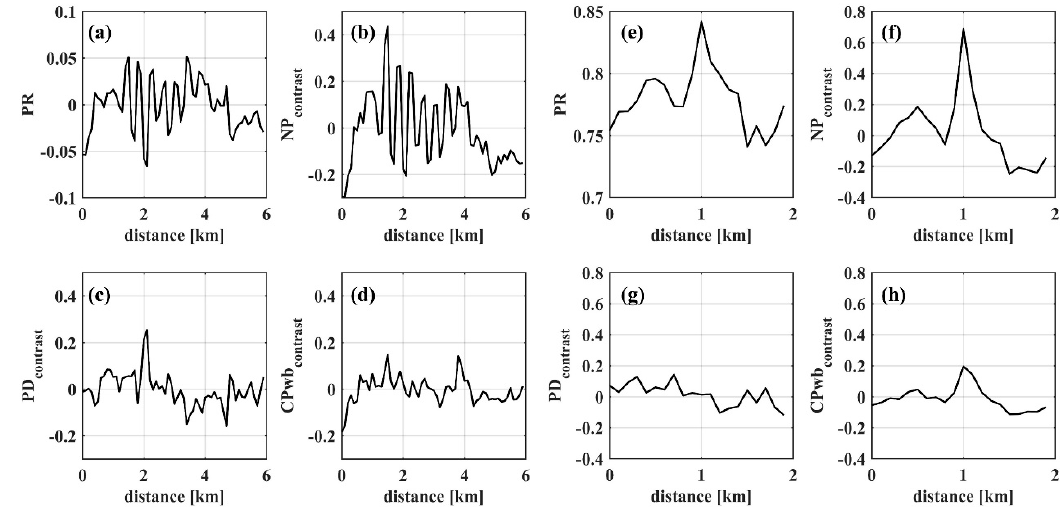
Figure 4. Transects across the IW train along the red arrow shown in Figure 3a: ( a ) PR, ( b ) NP contrast, ( c ) PD contrast, ( d ) CPwb contrast. Transects across the solitary IW along the blue arrow shown in Figure 3a: ( e ) PR, ( f ) NP contrast, ( g ) PD contrast, ( h ) CPwb contrast.